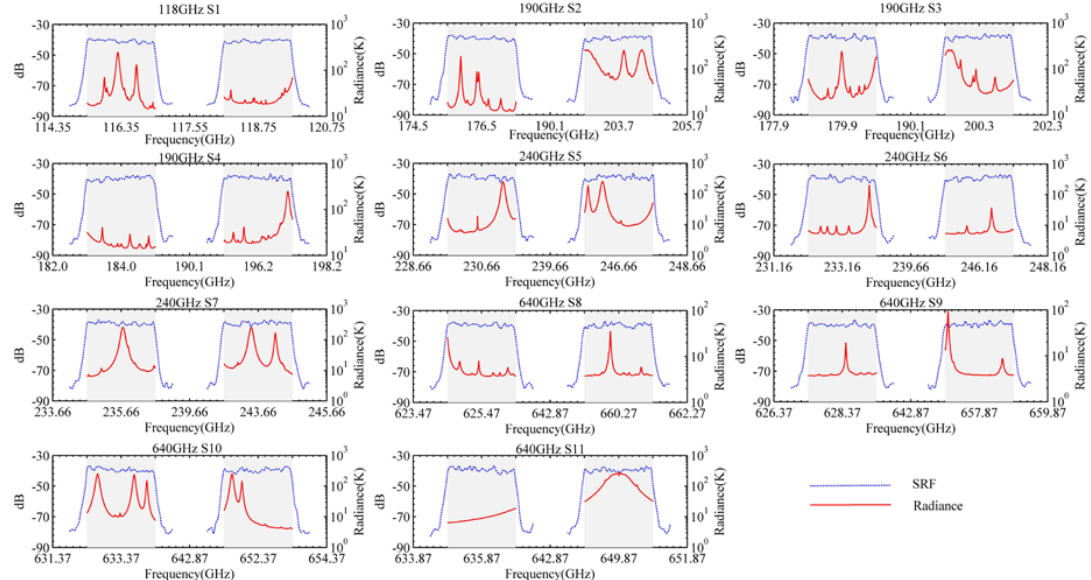
Figure 4. The spectral response functions (SRFs) of 11 bands of TALIS and the atmospheric radiance spectrum at the tangent height of 30 km. The red curve represents atmosphere radiance and the blue dotted line represents SRF.